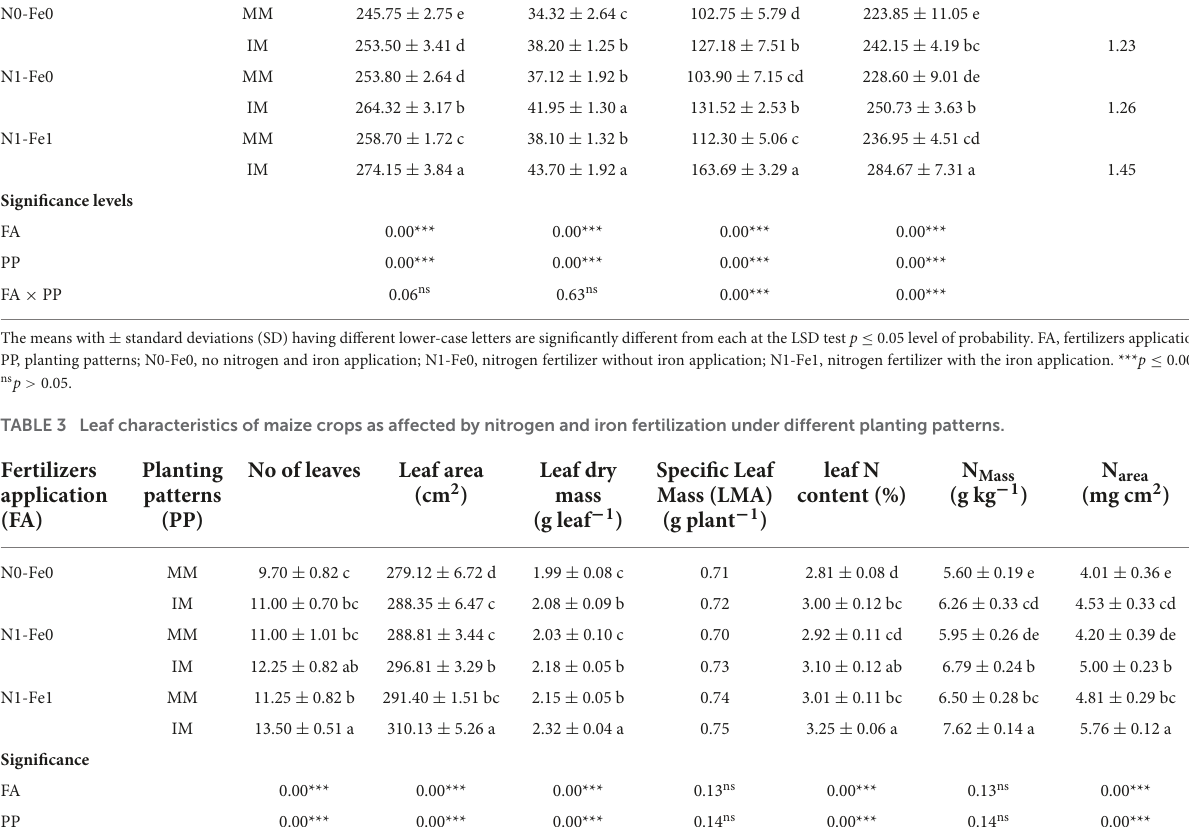
TABLE 2 Physio-agronomic indices of maize crops as influenced by nitrogen and iron fertilization under different planting patterns. Fertilizer application (FA)